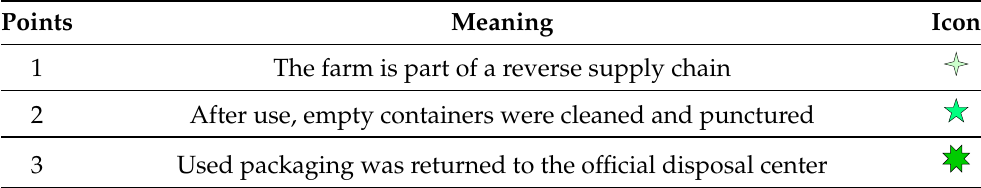
Table 3. Points, meaning and related icons.